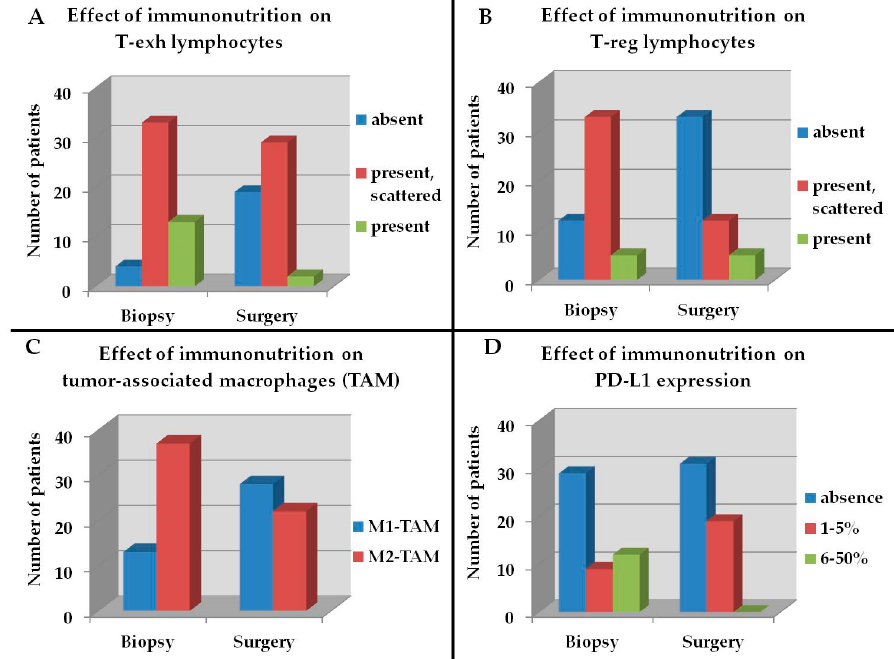
Figure 4. Modulation of TME of patients receiving IN from biopsy to surgical specimen. A , T ‐ exh lymphocytes; B , T ‐ reg cells; C , TAM; D , PD ‐ L1 expression. The differences were statistically significant for all cells evaluated ( p < 0.05).